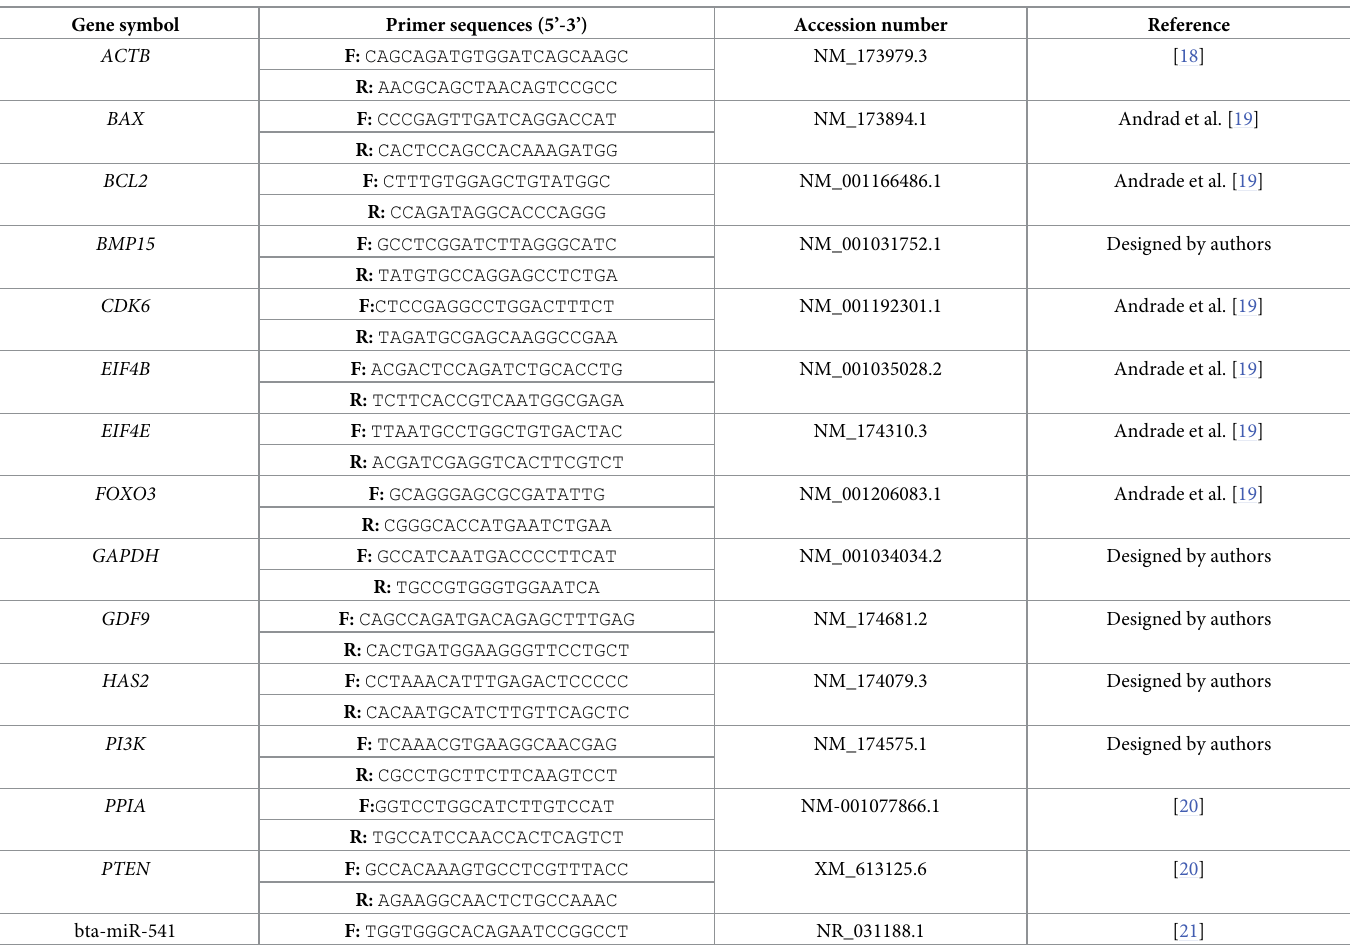
Table 1. Bovine primer sequences used in the RT-qPCR amplification. Gene